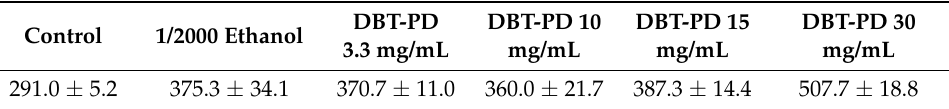
Table 2. Osmolality measurement of culture medium with different additives. Control 1/2000 Ethanol